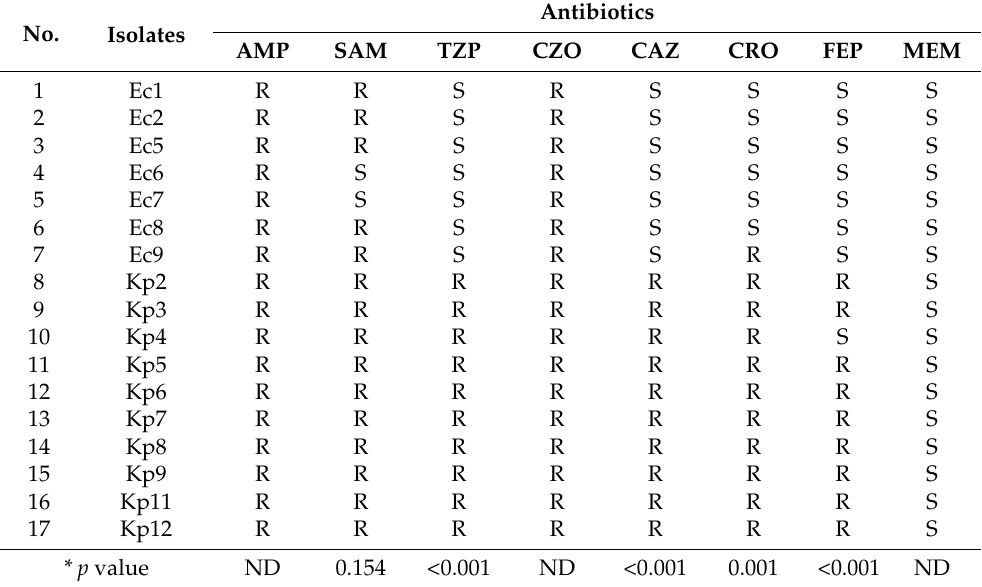
Table 4. Beta-lactam antibiotic susceptibility pattern of Escherichia coli and Klebsiella pneumoniae isolated from hospital wastewater. No. Isolates